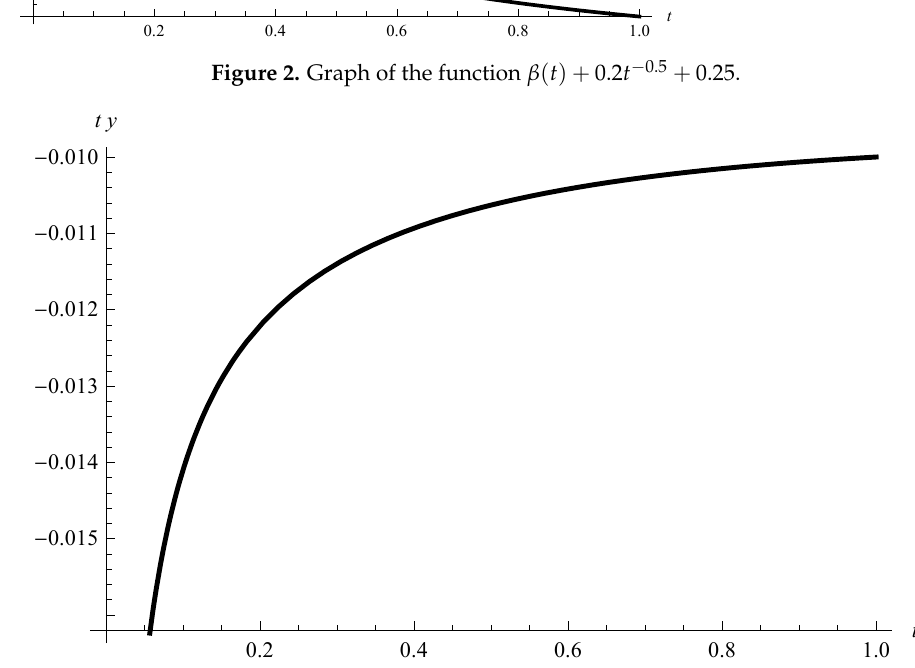
Figure 2. Graph of the function β ( t ) + 0.2 t − 0.5 + 0.25.